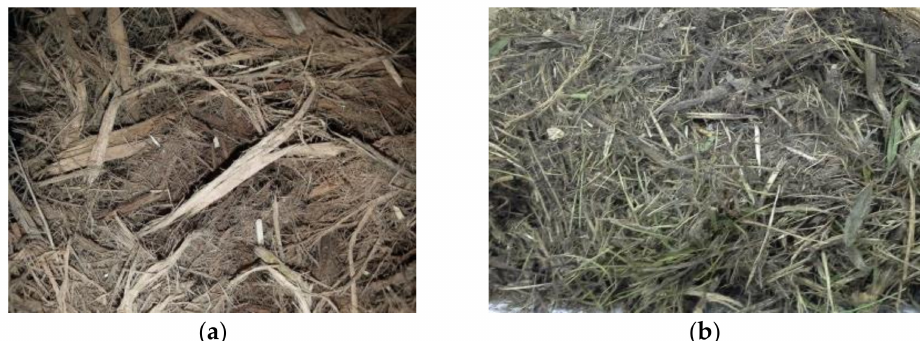
Figure 1. Eucalyptus globulus forest residues: ( a ) bark and ( b )